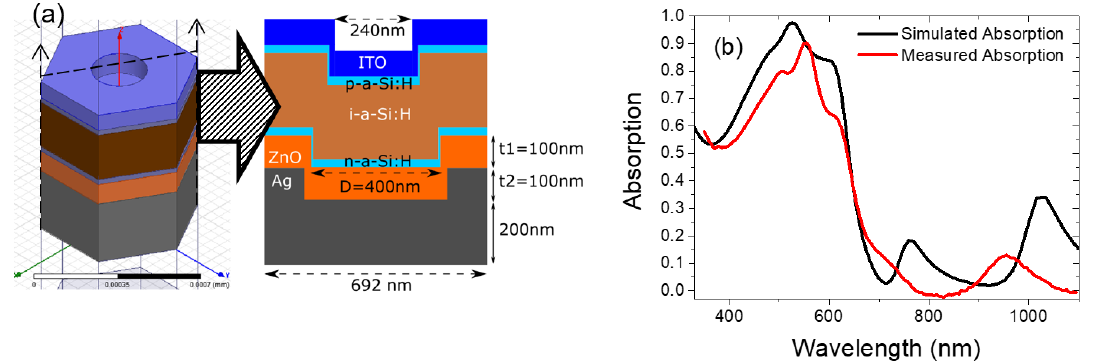
Figure 9. ( a ) High frequency electromagnetic field simulator (HFSS) simulation model for hexagonal BR solar cell; ( b ) Simulated and measured absorption of the plannar Ag/ZnO BR solar